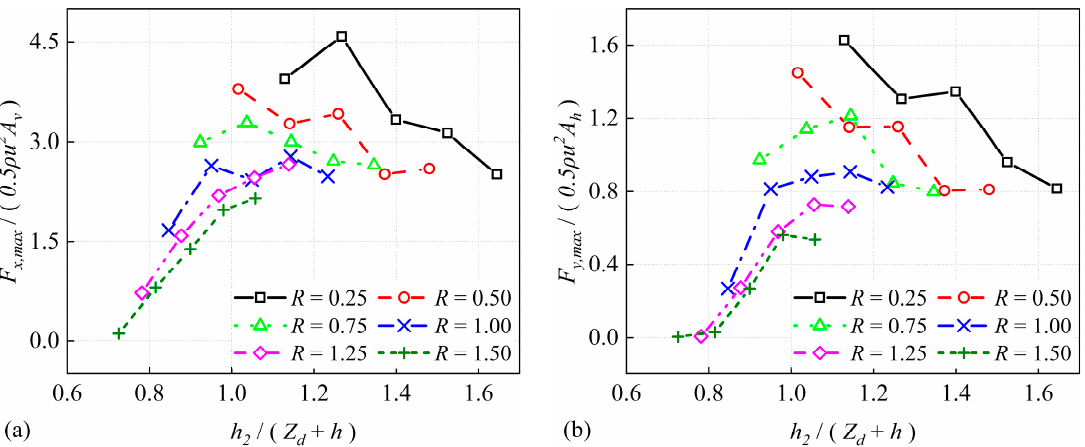
Figure 13. Normalized maximum tsunami forces at different relative wave heights: ( a ) horizontal tsunami force; ( b ) vertical tsunami force ( h 0 = 0.1 m).